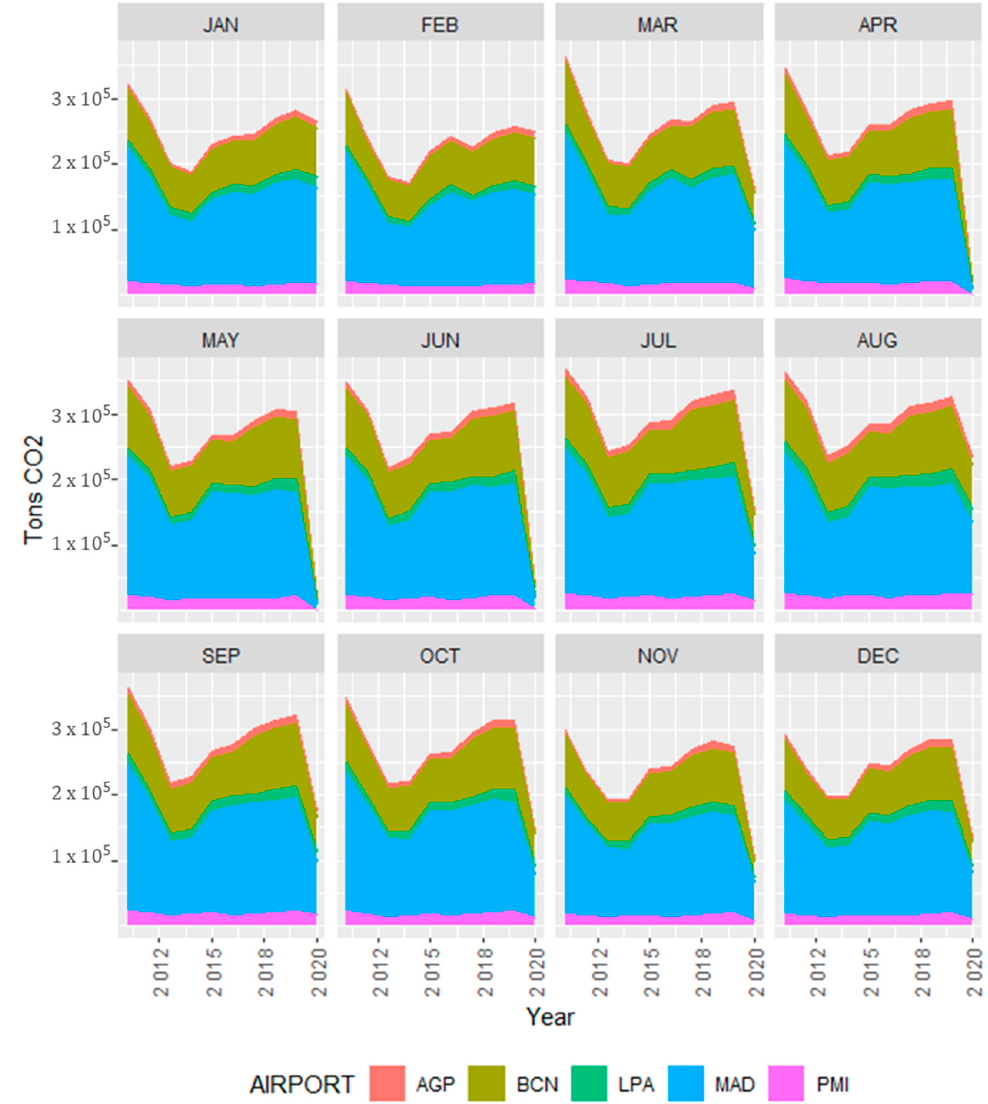
Figure 6. Monthly carbon dioxide emissions (disaggregated by each airport) between 2001 and 2020. Source: own calculation based on data published by [19] according to guidelines provided by [20].